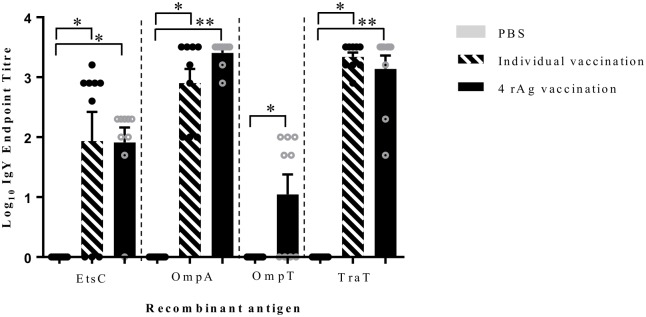
Serum IgY antibody response to vaccination.Data represents total serum IgY levels against individual recombinant antigens (rAg) induced in chickens vaccinated with either PBS (non-vaccinated), an individual antigen (EtsC, OmpA, or TraT), or with combined rAgs (EtsC, OmpA, OmpT, and TraT) in combination at day 29 post-vaccination. The serum from nine individual chickens/group were tested individually in duplicate. The values are shown as log10 IgY endpoint titer with mean ± SEM and individual animals are represented as dots. The grey bars are animals vaccinated with PBS (non-vaccinated), hashed bars represent animals vaccinated individually with EtsC, OmpA, or TraT (no individual vaccination was completed for OmpT), and black bars represent animals vaccinated with combined rAgs. Statistically significant differences were determined for each antigen compared to non-vaccinated by a Student’s T test, * indicates P < 0.05, and ** indicates P < 0.0001.